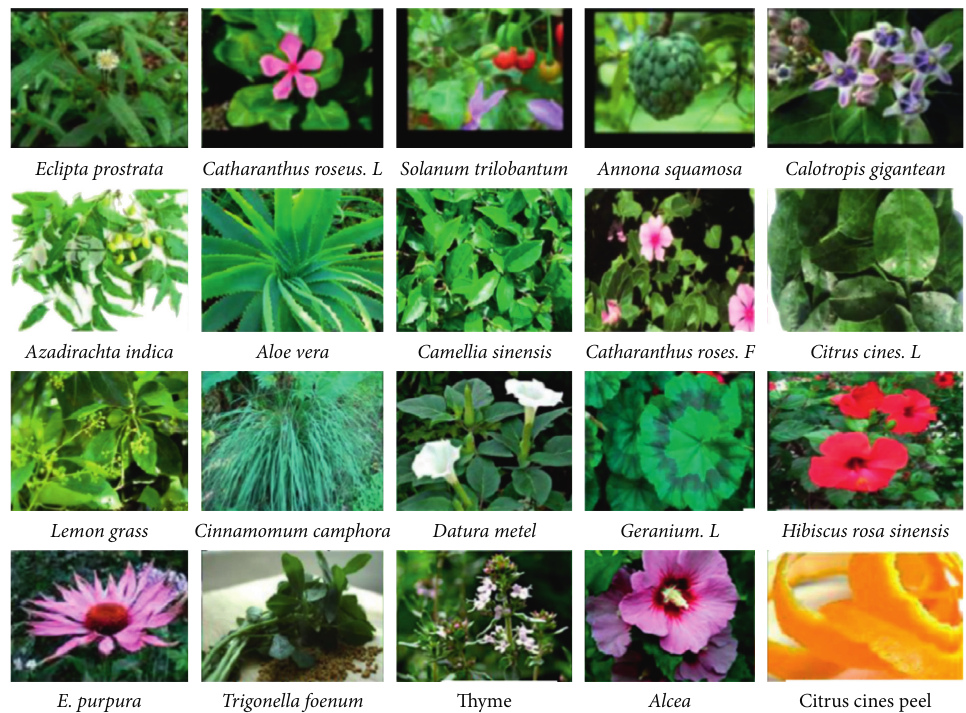
2 NPs synthesis [36, 37]. Washing Drying Grinding with DH 2 O (powder) Dissolve with green solvent Boiling React with Bioreduction Filtering Ti salts Figure 5: TiO 2 NPs synthetic pathway using plant extracts as green sources